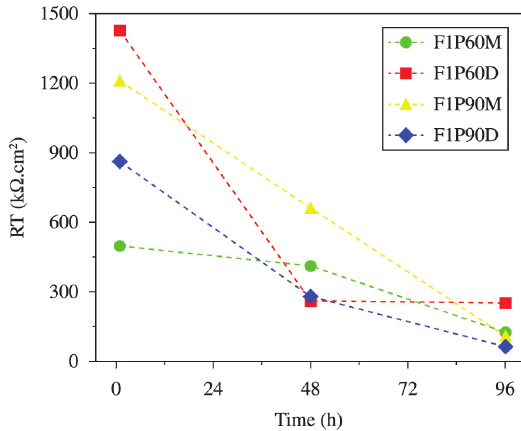
Figure 9. Evolution of the hybrid films resistance for F1P60M, F1P60D, F1P90M and F1P90D in a 0.05M NaCl solution with the immersion